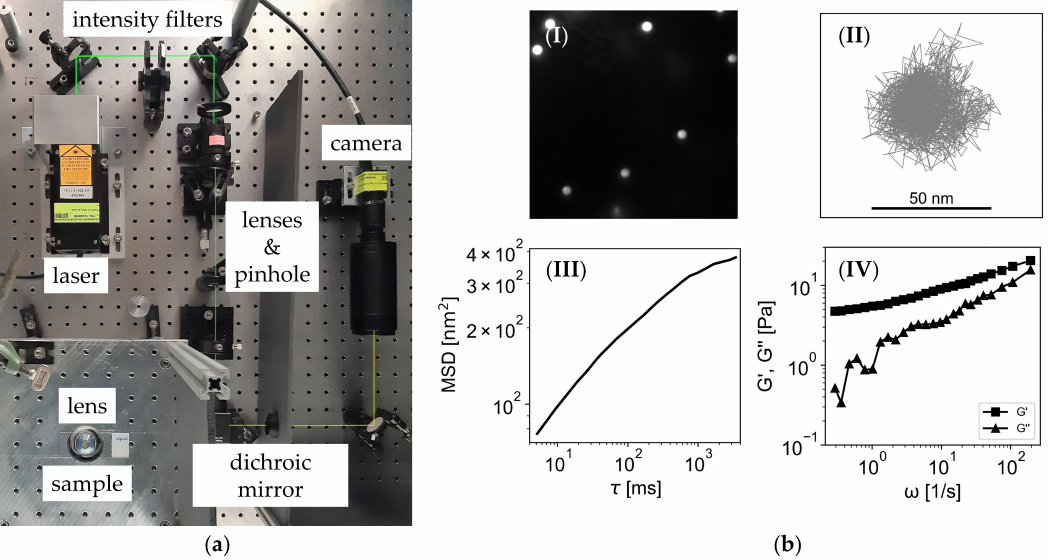
Figure 1. Particle tracking microrheology. ( a ) Measurement setup: A laser beam excited the fluorescent beads in the sample, which was placed on a lens with 100 × magnification. A camera tracked the movement of the fluorescent microspheres. ( b ) Evaluation of the measurement data. (I) Fluorescent microspheres in the sample. (II) Trajectory of a microspheres’ movement. (III) Mean square displacement (MSD) of a microsphere over lag-times ( τ ). (IV) Viscoelastic properties, storage (G’) and loss modulus (G”) of the micorspheres surrounding medium, calculated of the